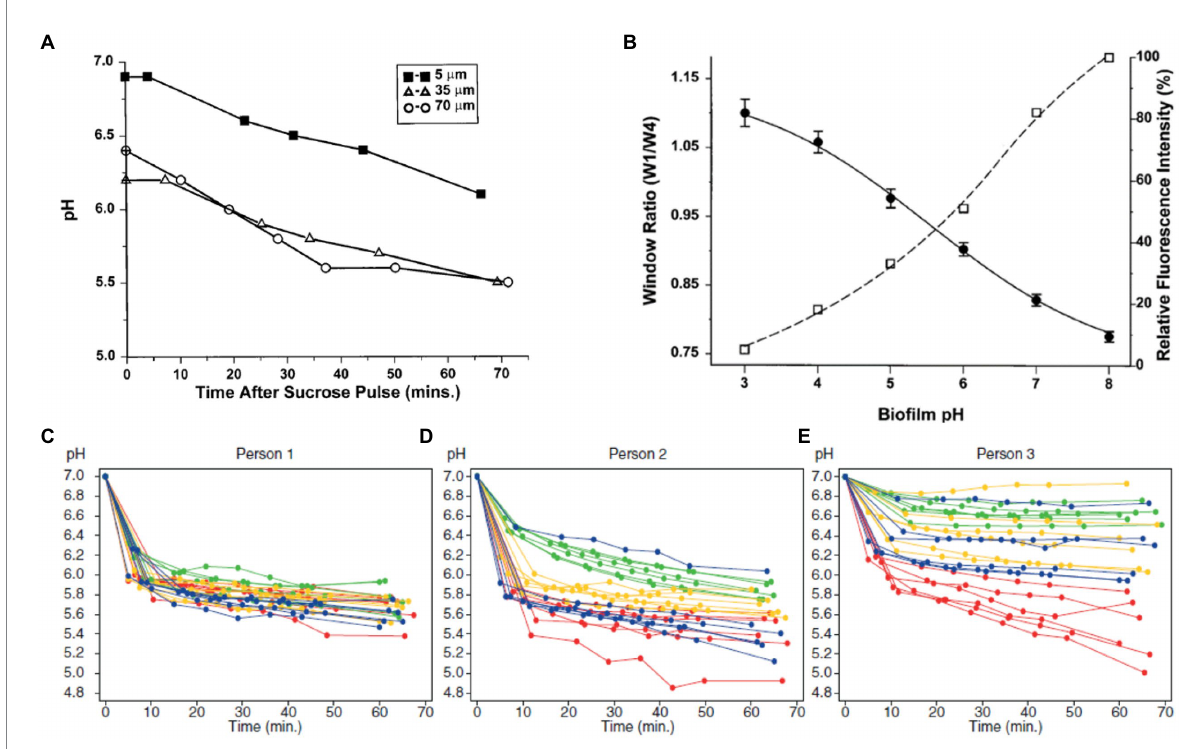
FIGURE 6 Time-dependent pH in oral biofilm after sucrose addition. (A) In a mixed culture of 10 oral bacteria grown in a chemostat system, the mean biofilm pH in a 100- μ m biofilm decreased following a sucrose pulse at depths of 5, 35, and 90 μ m from biofilm-coverslip assembly (Vroom et al., 1999). (B) Graph of window ratio (W 1 /W 4 ) vs. biofilm pH (solid line); graph of relative fluorescence intensity of carboxyfluorescein as a function of pH (dashed line; Vroom et al., 1999). (C–E) Extracellular pH curves of three individuals with different pH drop patterns in the sucrose-free group from 1-h experiment. Each curve shows the average pH of a field of view; different specimens are represented by the different colors (depth of biofilm: 10–35 μ m; Dige et al., 2016). These figures were reproduced with permission from Vroom et al. (1999) and Dige et al.